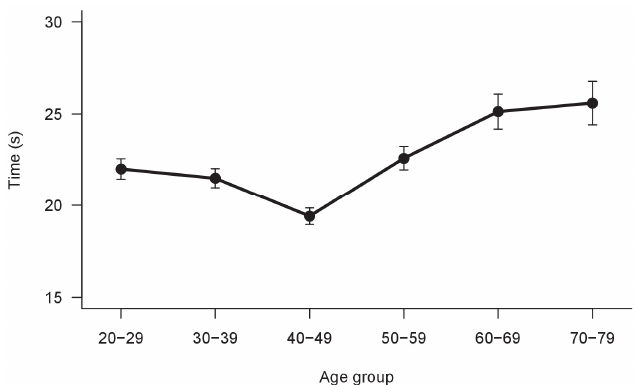
Figure 5. Mean execution times between age groups. Bars represent ±1 SEM.